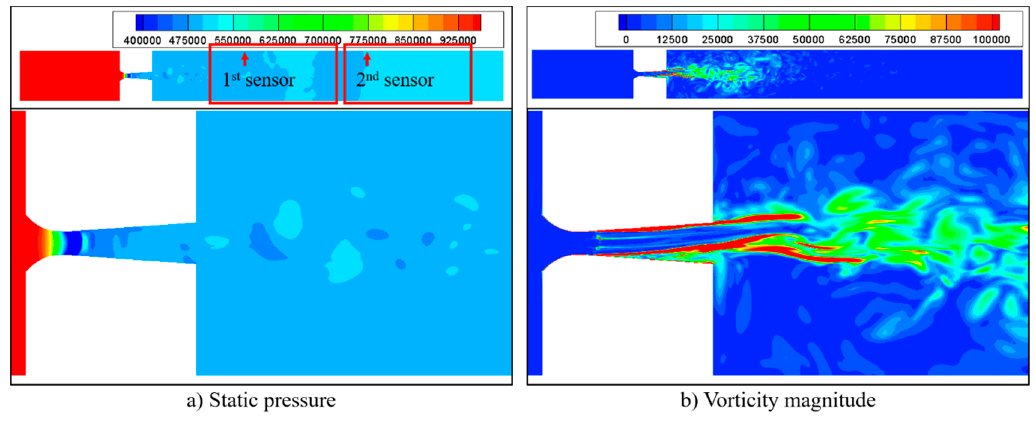
Figure 10. Steady RANS results: ( top ) static pressure (Pa) and ( bottom ) temperature (K).